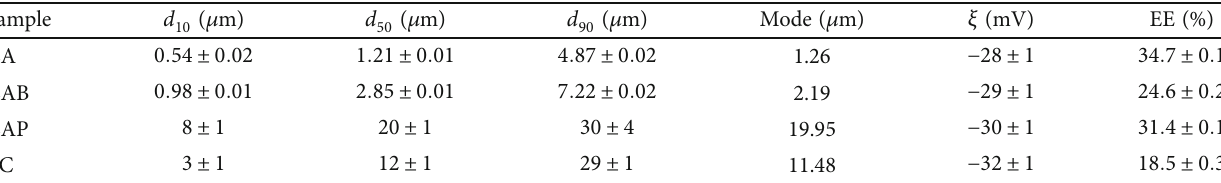
Table 1: Size, surface charge potential ( ξ ), and e ffi ciency of encapsulation (EE) of the eugenol-loaded CA, CAB, CAP, and EC microspheres, adapted from [31].